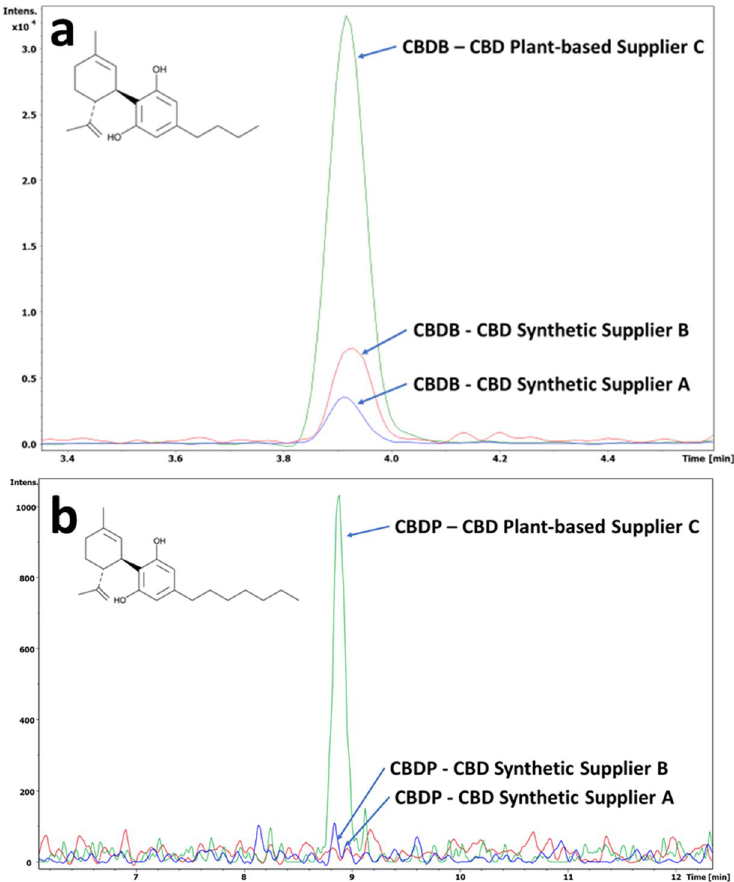
Figure 2. High-resolution extracted ion chromatogram of ( a ) CBDB [M + H] + at m/z 301.2157 and ( b ) CBDP [M + H] + at m/z 343.2632 of synthetic and plant-based CBD formulation